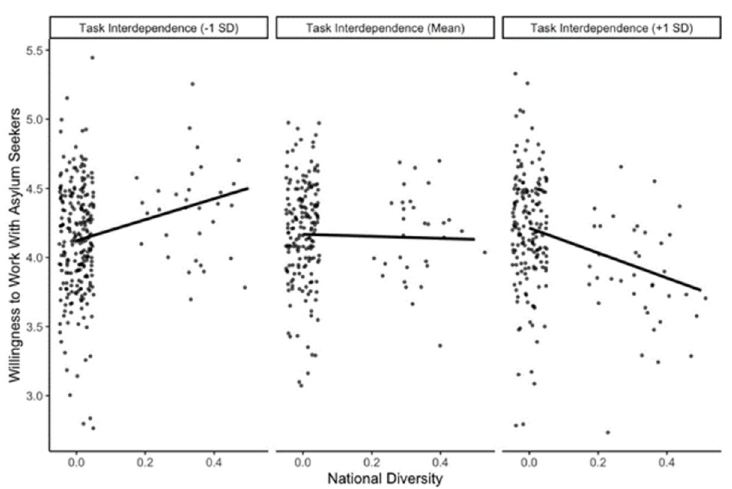
Fig 2. Significant interaction effect of task interdependence and nationality diversity on willingness to collaborate with asylum seekers controlled for control variables.